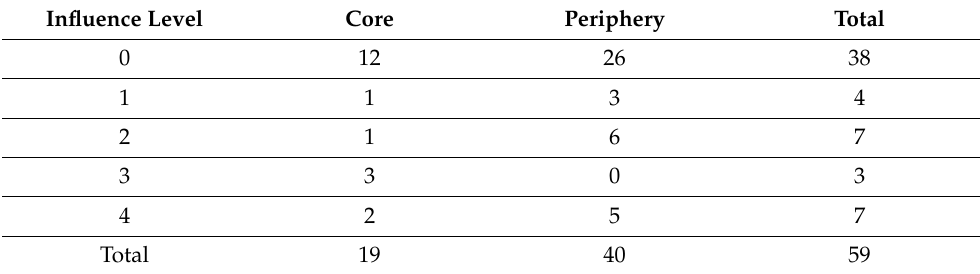
Table 4. Distribution of influence across core and periphery.